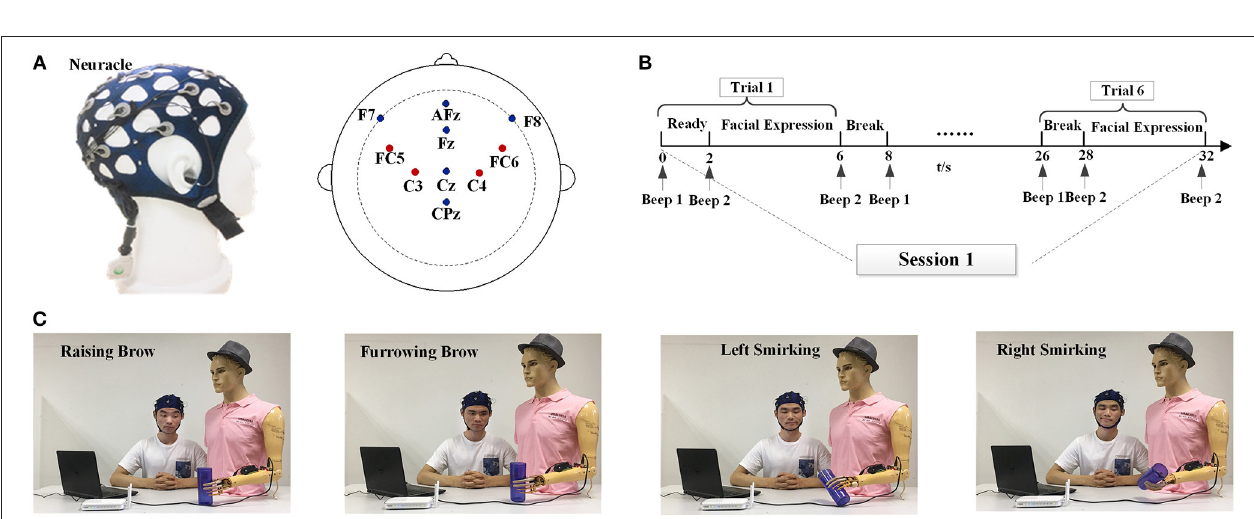
FIGURE 2 | Experimental setup and task description. (A) The Neuracle device and its electrode placements. (B) Overview of the time series of one session. (C) The experiment scene with one subject (S3) to illustrate the four facial expression tasks used for prosthesis movements. Raising Brow corresponds to hand opened, Furrowing Brow corresponds to hand closed, Left Smirking corresponds to wrist rotation to the right, and Right Smirking corresponds to wrist rotation to the left. Written informed consent for the publication of identifying images was obtained from the subject (S3).